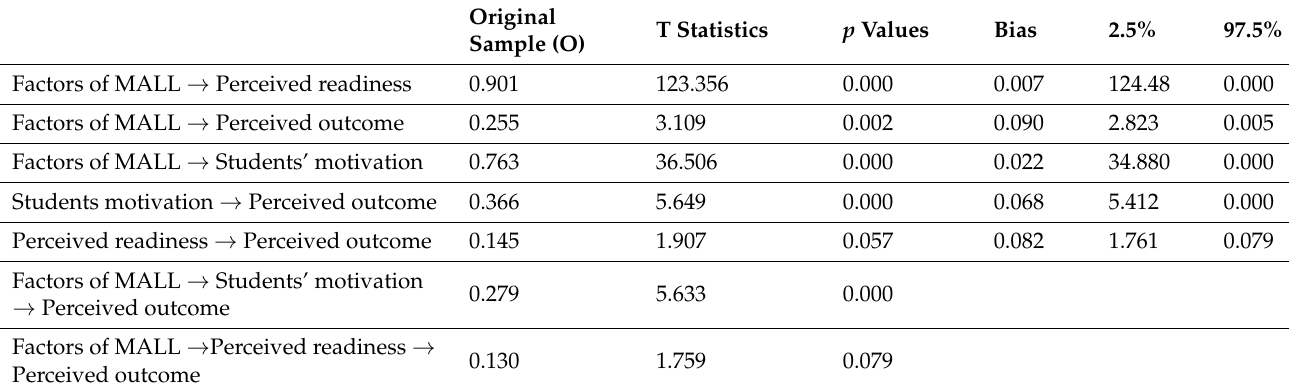
Table 9. Path coefficient and confidence